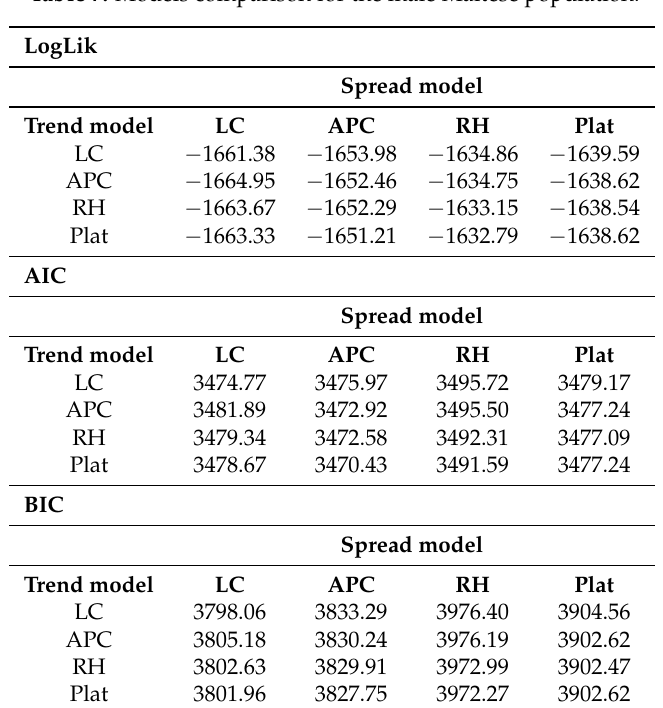
Table 7. Models comparison for the male Maltese